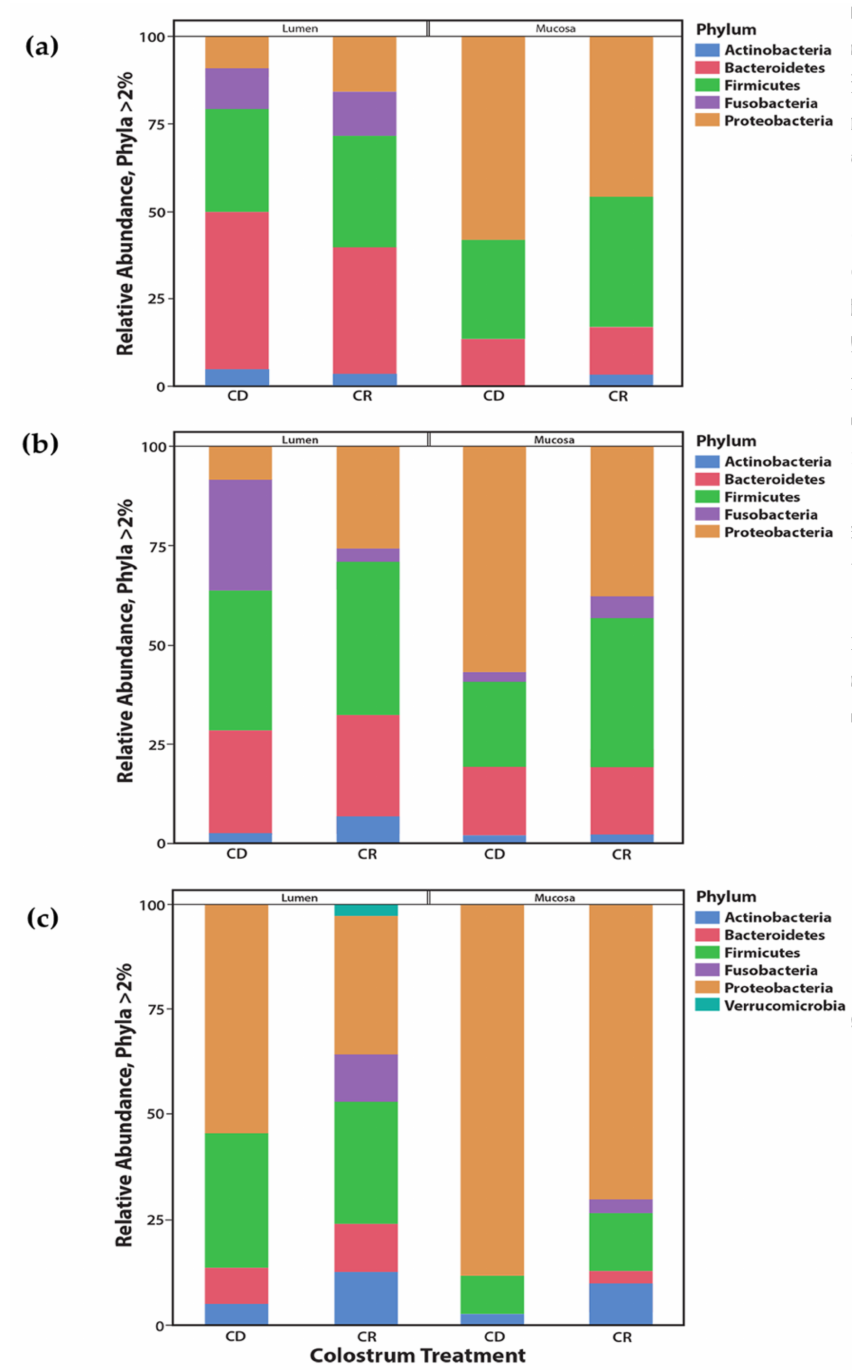
Figure 5. Relative abundance of microbial populations was calculated for each tissue and compared for each sample using the package ‘phyloseq’ and ‘tax_glom’ functions, respectively. Phyla that contributed more than 2% of the relative abundance of each sample were included in the analysis. Stacked bar plots of Phyla abundance were plotted against sample, for each tissue, using the package ‘ggplot2 (cid:48) . Mean relative abundance in the lumen contents and mucosa of the spiral colon ( a ), cecum ( b ), and ileum ( c ) in calves not fed colostrum, CD = colostrum deprived, and calves fed colostrum, CR = colostrum replacer. Mean phylum relative abundance di ff erences between lumen and mucosa across all three tissues were apparent for Phylum Proteobacteria, p < 0.0001 and Phylum Bacteroidetes, p <